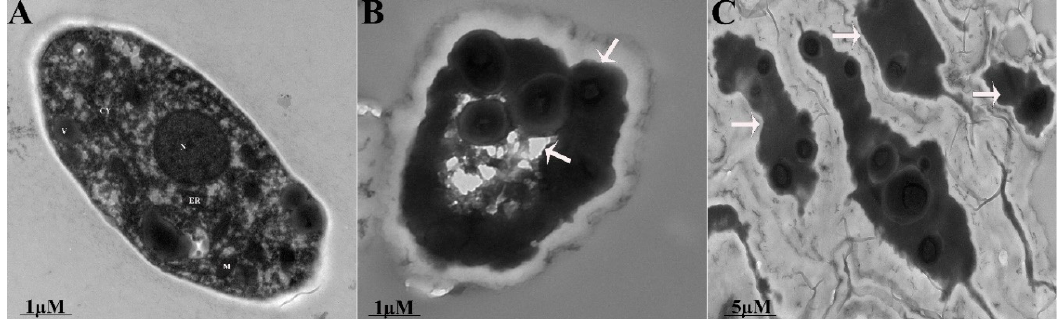
Figure 5. Ultra-structural deformities observed in the mycelium of S. sclerotiorum under a transmission electron microscope: ( A ) control ( B and C ) treated with fengycin (20 µg/mL). CY = cytoplasm, N = nucleus, ER = endoplasmic reticulum, V = vacuole, and M = mitochondria.